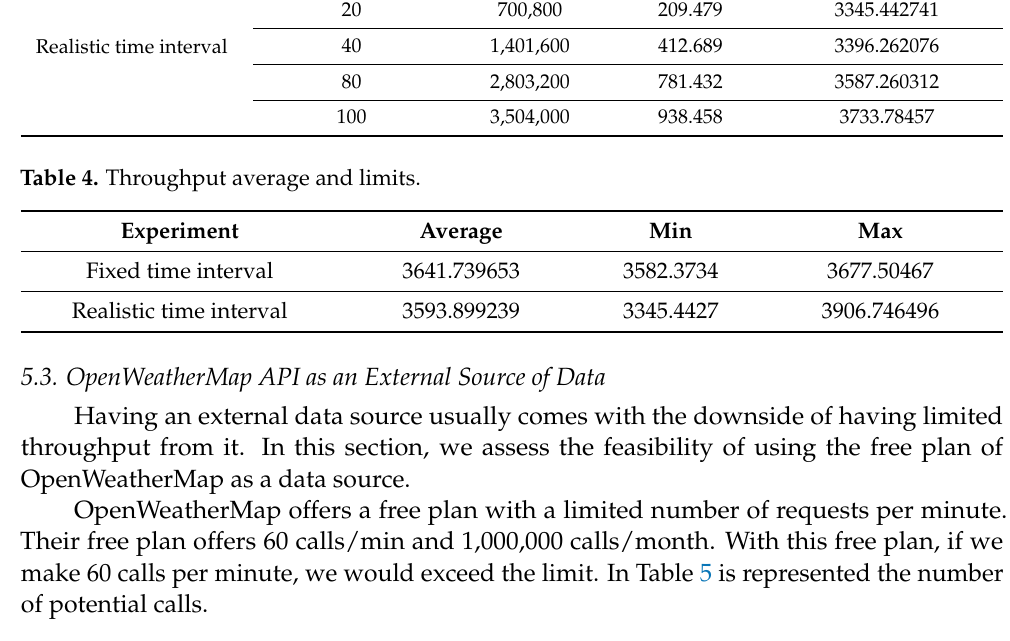
Table 5. Number of total calls/month with 60 calls/minute.